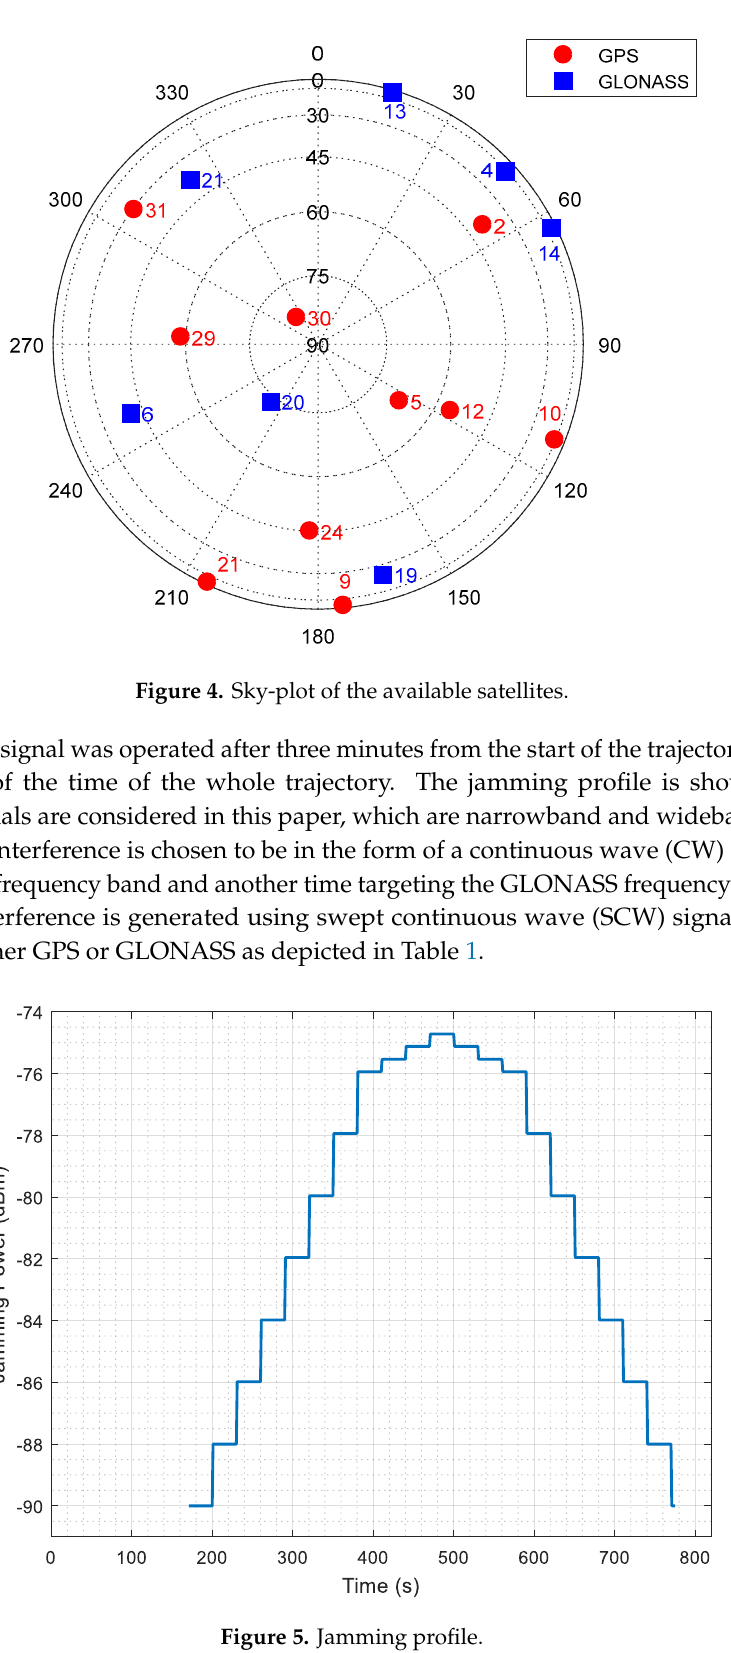
Figure 5. Jamming profile. Table 1. Jamming signal specifications.